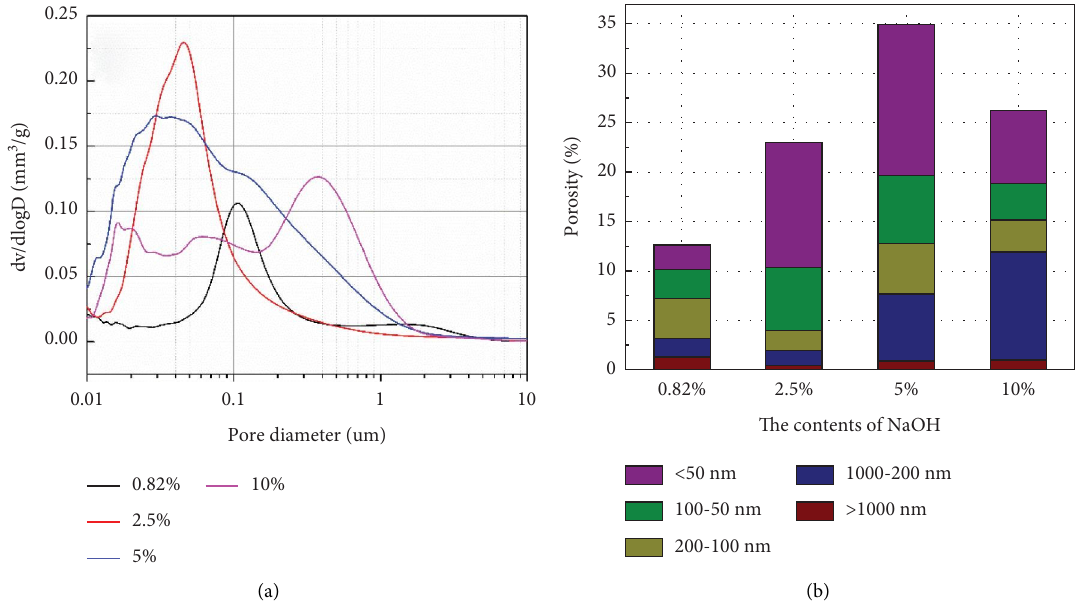
Figure 14: Te pore structure of the SFCM with diferent sodium hydroxide contents after curing at 90 ° C for 28 d. (a) Distribution curve; (b) porosity ratio.